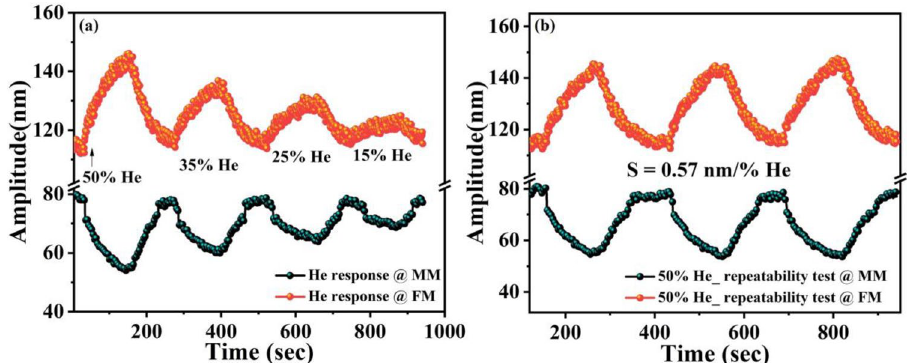
Figure 12. Response of simultaneously actuated vibration modes (V ac = 0.75 V, f o1 30.65 kHz at mass mode MM and V